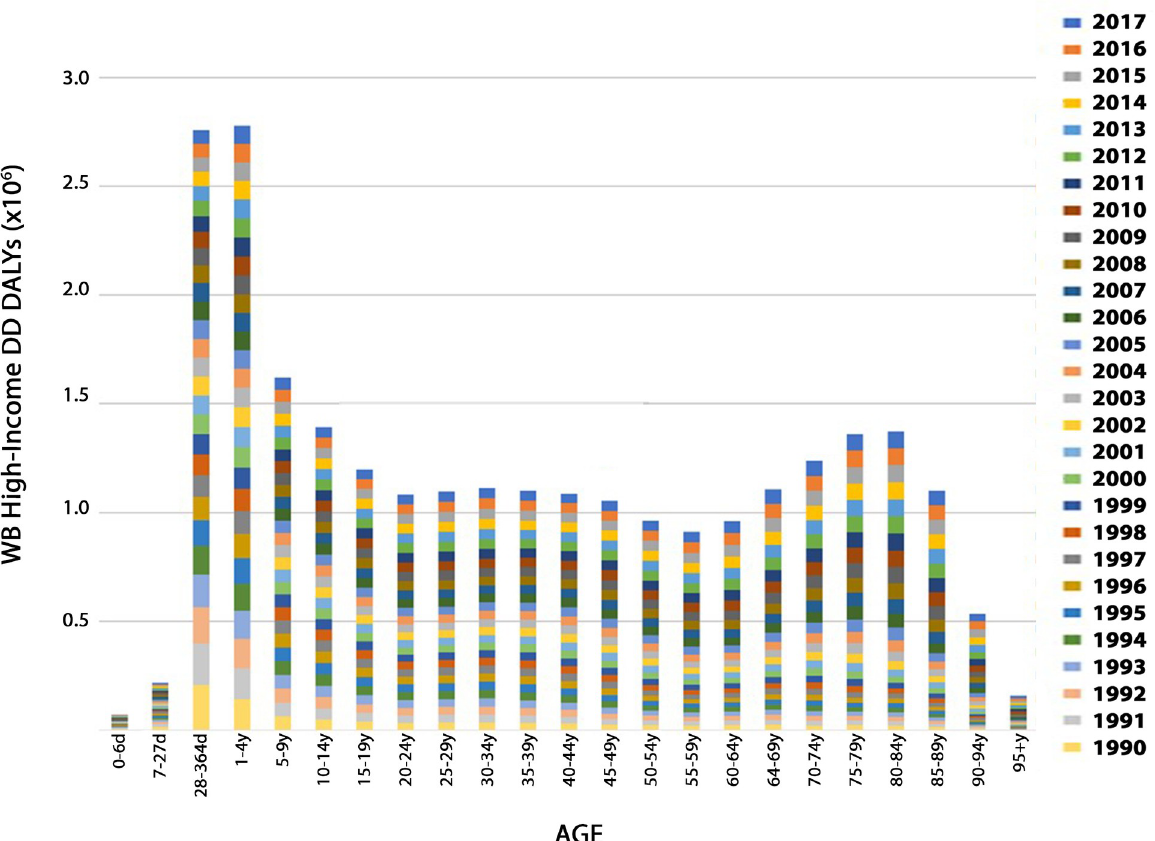
Fig 8. The relationship between age-standardized DD DALY and age for WB high-income countries. Age is given in days (d) or years (y). For each age class (bar), the sum of annual DD DALYs from 1990–2017 are presented.